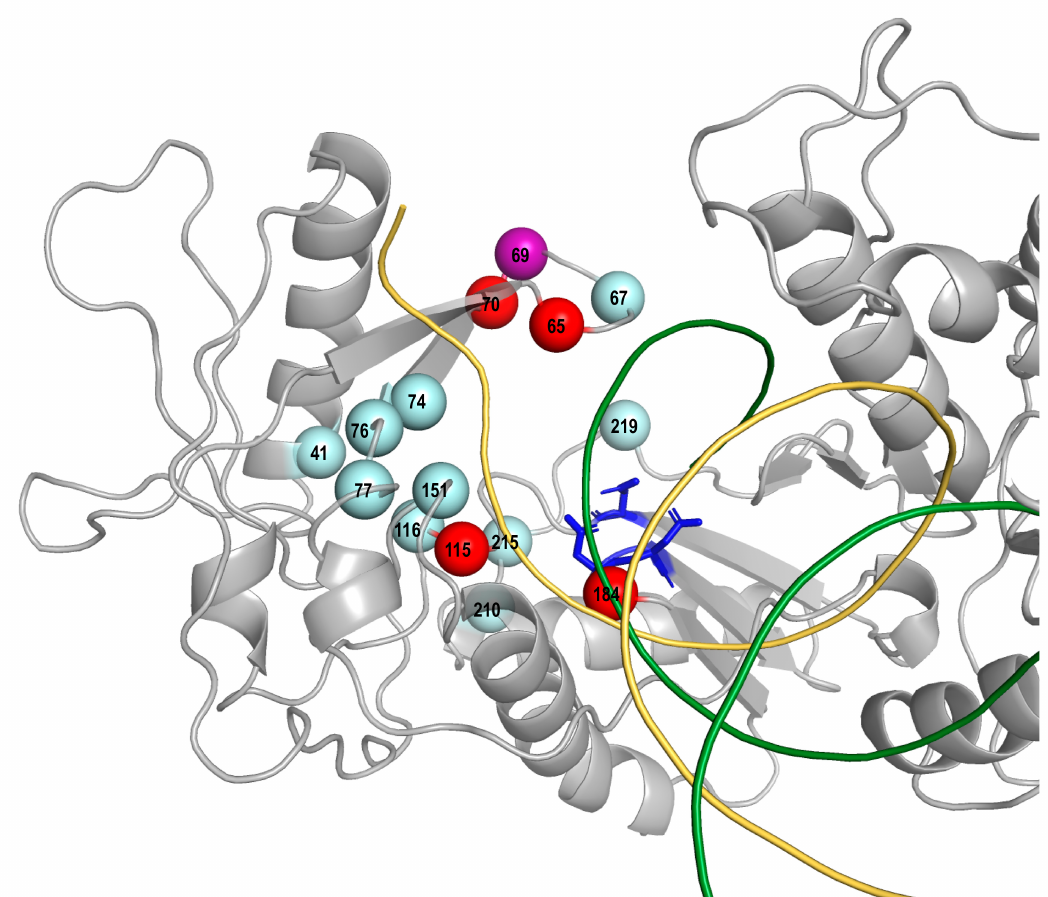
Figure 1. Three-dimensional structure (PDB accession number 1RTD) of HIV-1 RT showing the p66 monomer in grey. The active site residues D110, D185 and D186 are shown in stick mode in blue, a DNA template and a primer are shown in ribbon mode in yellow and green, respectively. Red spheres indicate four SDRM positions at which SDRMs including K65R, K70E, Y115F, and M184V/I and tenofovir-associated non-SDRMs (K70Q/T) increased in prevalence since 2009 in NRTI-experienced persons. A purple sphere indicates a SDRM position at which tenofovir-associated non-SDRM T69deletion increased in prevalence since 2009 in NRTI-experienced persons. Spheres in cyan indicate SDRM positions at which SDRMs decreased or did not change in prevalence since 2009 in NRTI-experienced